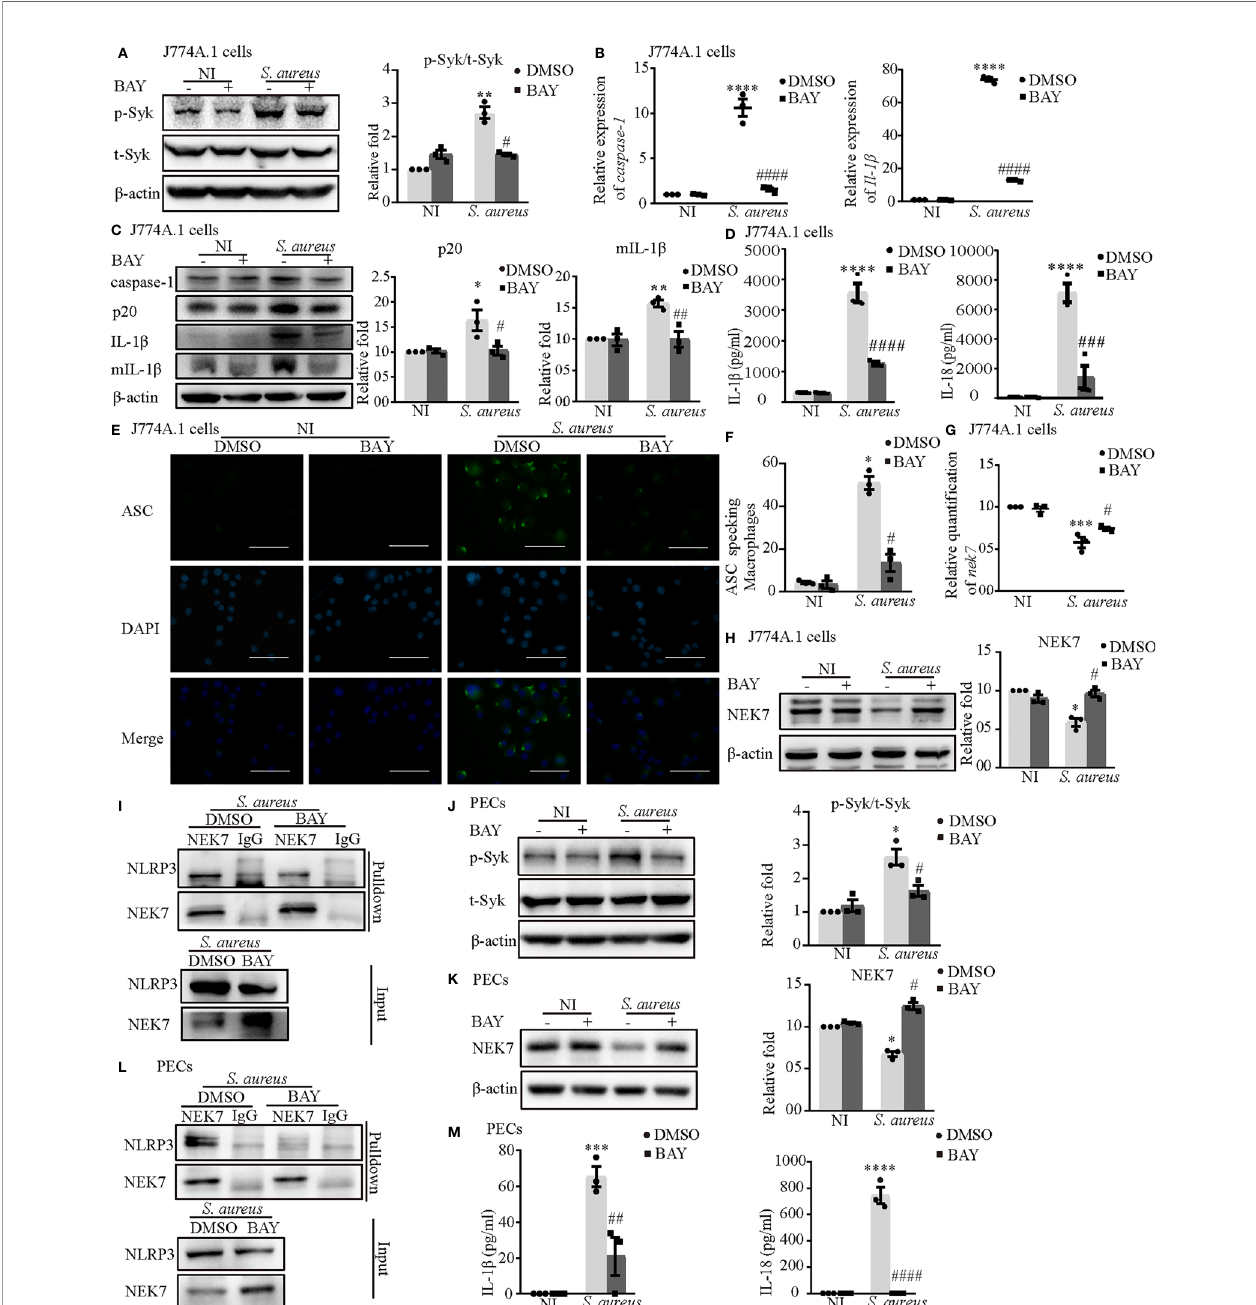
FIGURE 6 | Phosphorylated Syk was involved in S. aureus infection-induced NEK7-NLRP3 signaling pathway activation. J774A.1 cells (A – I) and PECs (J – M) pretreated with or without Syk inhibitor (BAY 613606) at the fi nal concentration of 1 m mol/L for 2 h followed by S. aureus infecton (MOI of 1 or 5) for different time. (A) The protein levels of t-Syk and p-Syk were detected by western blot and analyzed by relative densitometric quanti fi cation followed by S. aureus infection (MOI of 5) for 30 min in J774A.1 cells and PECs (J) . (B) The mRNA expression levels of caspase-1 and Il-1 b were quanti fi ed by RT-PCR. (C) The protein expression levels of caspase-1, p20, pro-IL-1 b and mIL-1 b were detected by western blot and analyzed by relative densitometric quanti fi cation. (D) The supernatants were collected at 48 h after S aureus infection. IL-1 b and IL-18 in the supernatants were determined by ELISA in J774A.1 cells and PECs (M) . (E) The ASC specks formation were imaged via fl uorescence microscopy. (Scale bar: 100 µm.). (F) ASC specks were quantitied in more than 200 cells from at least 5 different fi elds. (G) The mRNA expression level of nek7 was examined by RT-PCR. (H) The protein expression level of NEK7 was detected by western blot and analyzed by relative densitometric quanti fi cation in J774A.1 cells and PECs (K) . (I) The NEK7-NLRP3 compound were analysed by coimmunoprecipitation in J774A.1 cells and PECs (L) . Similar results were obtained in three independent experiments in data. Data shown are means ± SEMs; * P < 0.05, ** P < 0.01, *** P < 0.001, **** P < 0.0001 vs . non- infection control group, # P < 0.05, ## P < 0.01, ### P < 0.001, #### P < 0.0001 vs. infection control